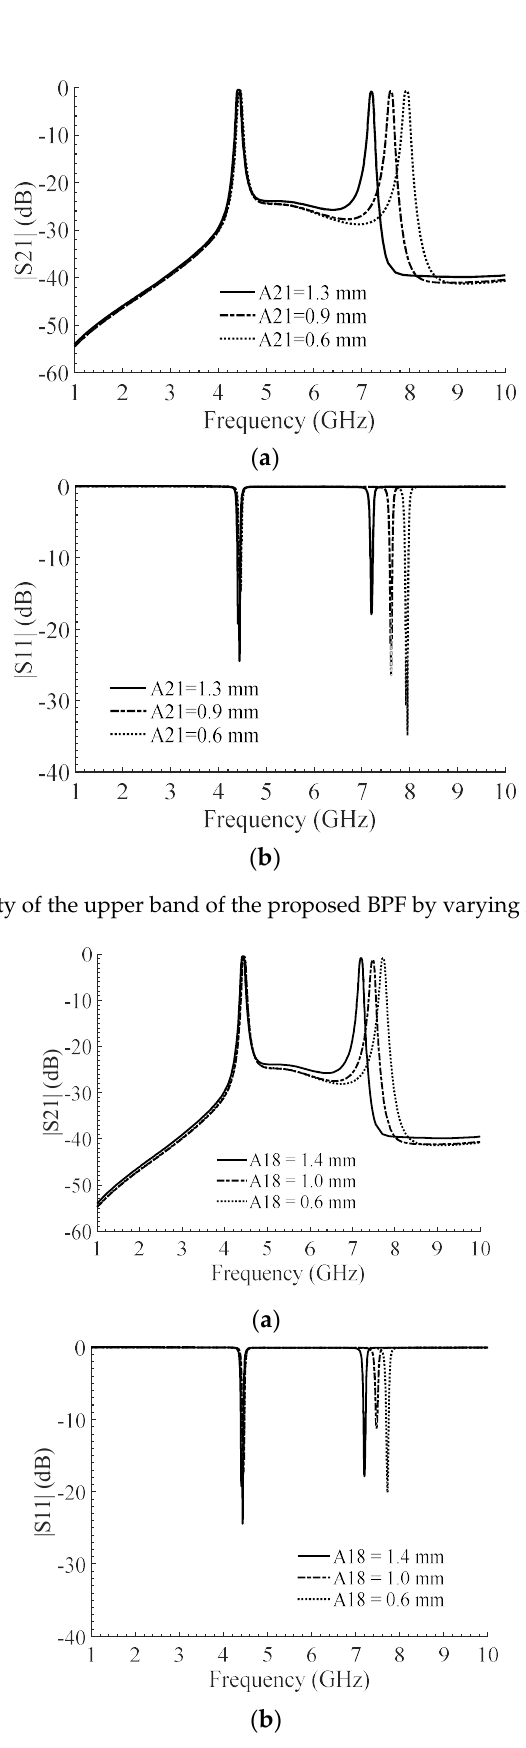
Figure 10. Adjustability of the upper band of the proposed BPF by varying A 18 : ( a ) |S 21 |, ( b ) |S 11 |.